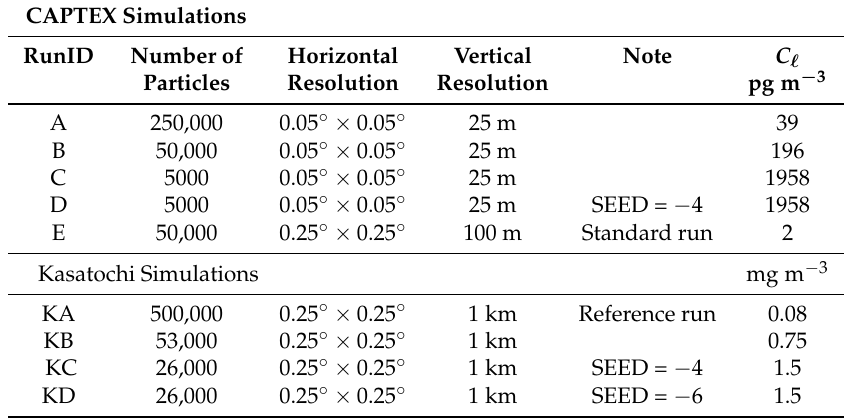
Table 1. Summary of HYSPLIT simulations. RunC and RunD are identical except for the random seed which was used in the simulation. C l is given in Equation (2). For the CAPTEX simulations, the number of particles is the number of particles released over the 3 h emission period. For the Kasatochi simulations the number of particles is approximately the total number of particles released over 8